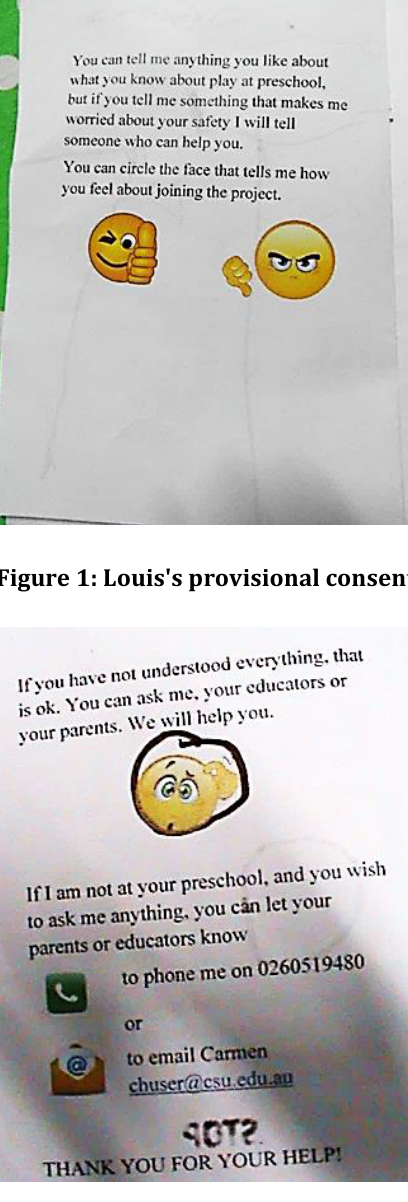
Figure 2: Sienna's assent: being